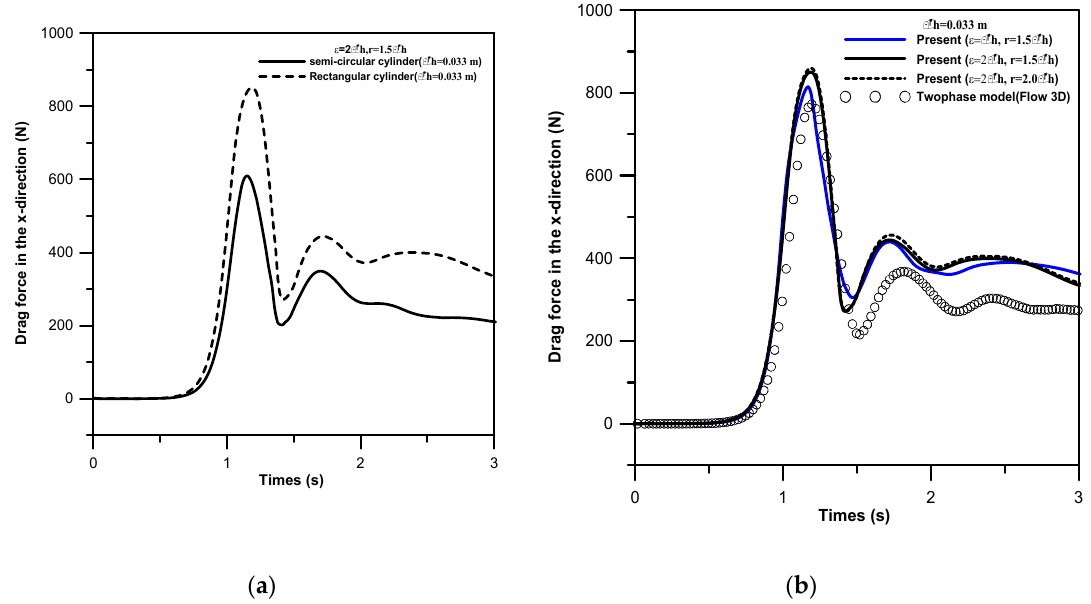
Figure 13. Time variations of drag force (N): ( a ) semicircular cylinder vs. rectangular cylinder and ( b ) rectangular cylinder.